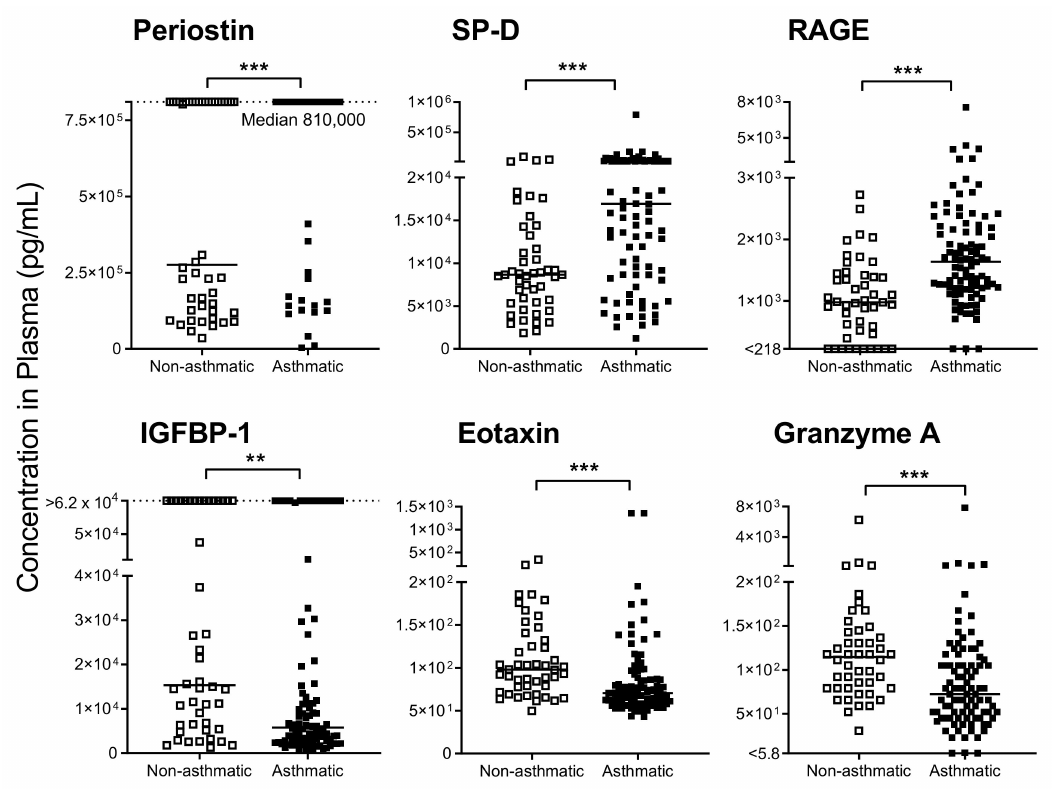
Figure 1. Immune mediators in plasma were altered in asthmatics compared to hospitalized nonasthmatics. Significant di ff erences were observed in plasma immunomodulators between asthmatics and controls. Dotted lines are indicative of upper limits of detection (LOD). Solid lines show the median in each group. For surfactant protein-D (SP-D), receptor for advanced glycation end products (RAGE), eotaxin and granzyme A, data were analyzed by Mann-Whitney U tests with significance marked by *** p < 0.001. For periostin, the Fisher’s exact test was used to compare patient populations for scores above / below the upper LOD (*** p < 0.001). For insulin growth factor binding protein (IGFBP-1), the Fisher’s exact test was used to compare patients for scores above / below 5000 pg / mL (** p <